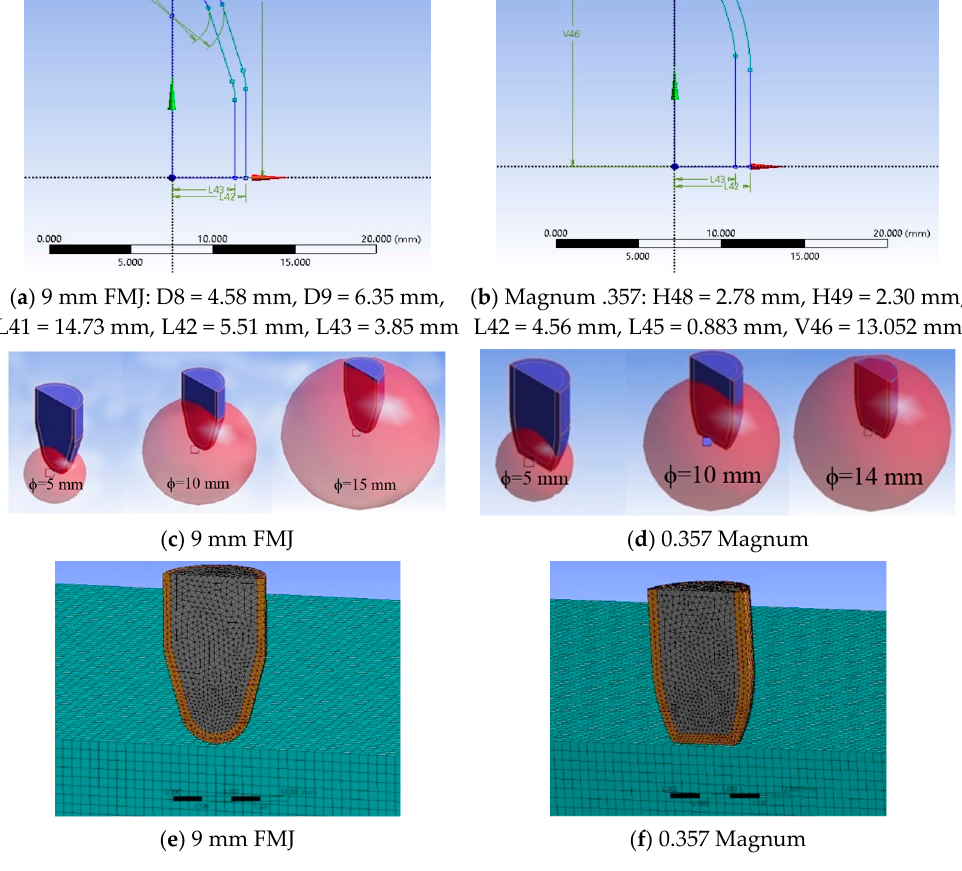
Figure 3. ( a , b ) Geometry of the projectiles, ( c , d ) influence spheres with graduate mesh elements for 9 mm FMJ and for .357 Magnum, ( e , f ) details of meshing for the projectiles and panel. For both projectiles, a tetrahedral network with at least two elements on the jacket thickness was used, obtained from an initial discretization, over which a mesh with three spheres of influence with increasing radii was added, the smallest sphere having the finest mesh (Figure 3), in order to have a relatively controlled growth of elements. For the first sphere, the element size was 0.35 mm, for the next sphere, it was 0.45 mm and for the largest one, it was 0.55 mm (Figure 3c,d). The panel had a surface of 120 mm × 120 mm. The actual panel was 300 mm × 300 mm, allowing for three hits at a distance of 120 mm, forming an equilateral triangle, as required by the standard EN 1523:2004 Windows, doors, shutters and blinds. Bullet resistance. Test method. The simulation was run for only one hit on a smaller surface, but large enough to cause delamination.